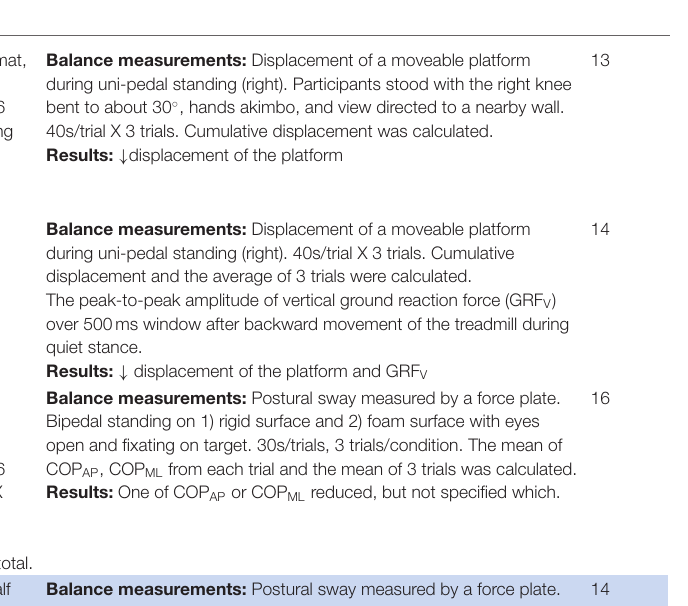
TABLE 2 | Summary of participant characteristics, training, balance outcomes, and the quality of the papers. Type